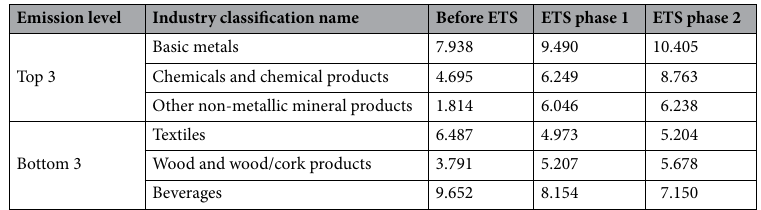
Table 1. Average carbon productivity by industry. Industries were classified using the 2-digit Korean Standard Statistical Classification (KSIC) codes (http:// kssc. kostat. go. kr/ ksscN ew_ web/ ekssc/ main/ main.